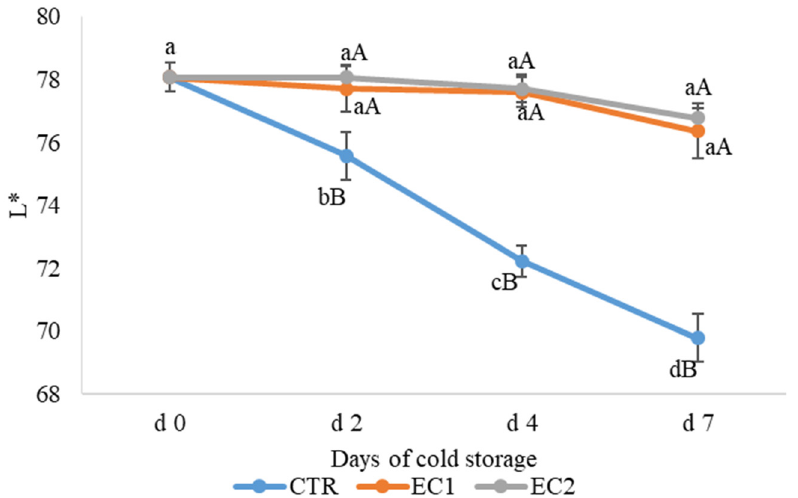
Figure 2. Development of lightness (L*) of treated (EC1 and EC2) and untreated (CTR) pear slices. Data correspond to the means ± standard deviation of three replicates. Means with different letters are significantly different at p ≤ 0.05 using Tukey’s-HSD test. Different lowercase letters denote significant differences ( p < 0.05) between different sampling times for the same treatment. Different capital letters denote significant differences ( p < 0.05) between different treatments for the same sampling time.